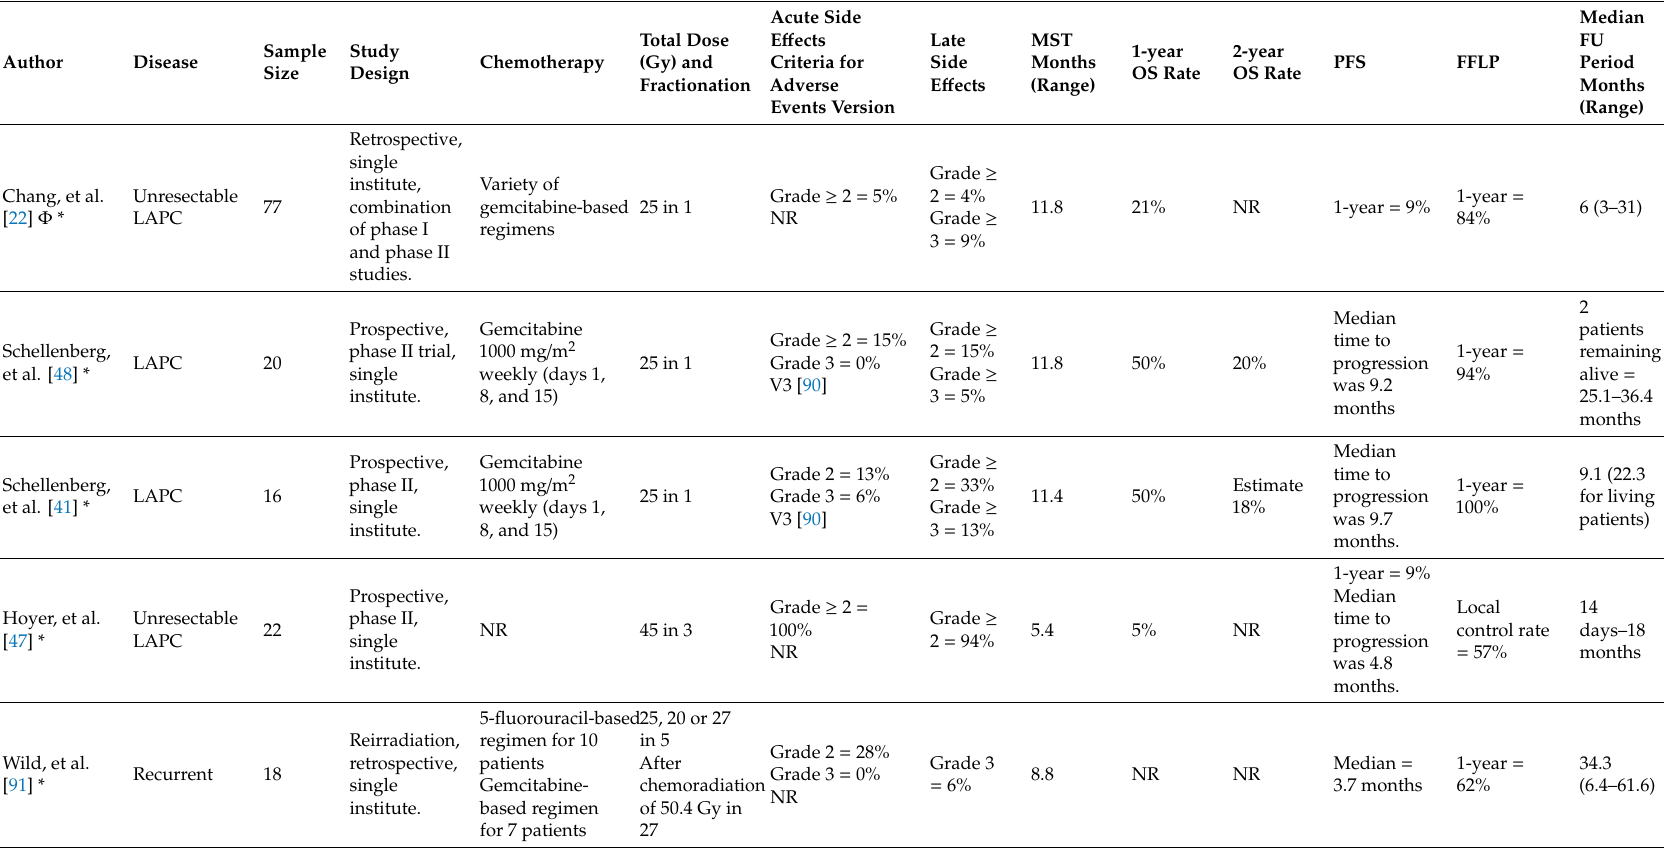
Table 2. Review of stereotactic body radiation therapy (SBRT) pancreatic cancer clinical studies